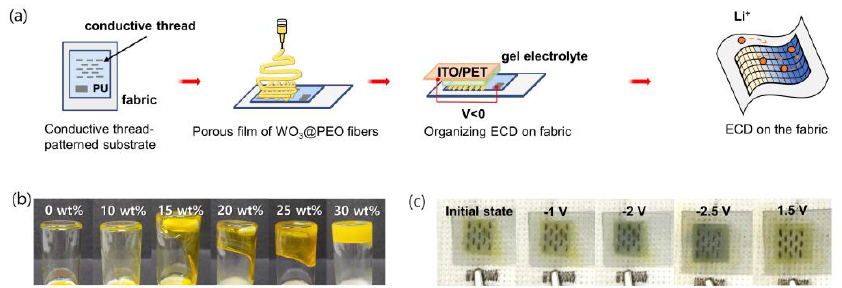
Figure 6. ( a ) Schematic image for fabrication of an ECD on the fabric; ( b ) photographs of the gel- electrolytes for different amounts of PEO in the solution; ( c ) photographs of ECD on fabric at different voltage steps.